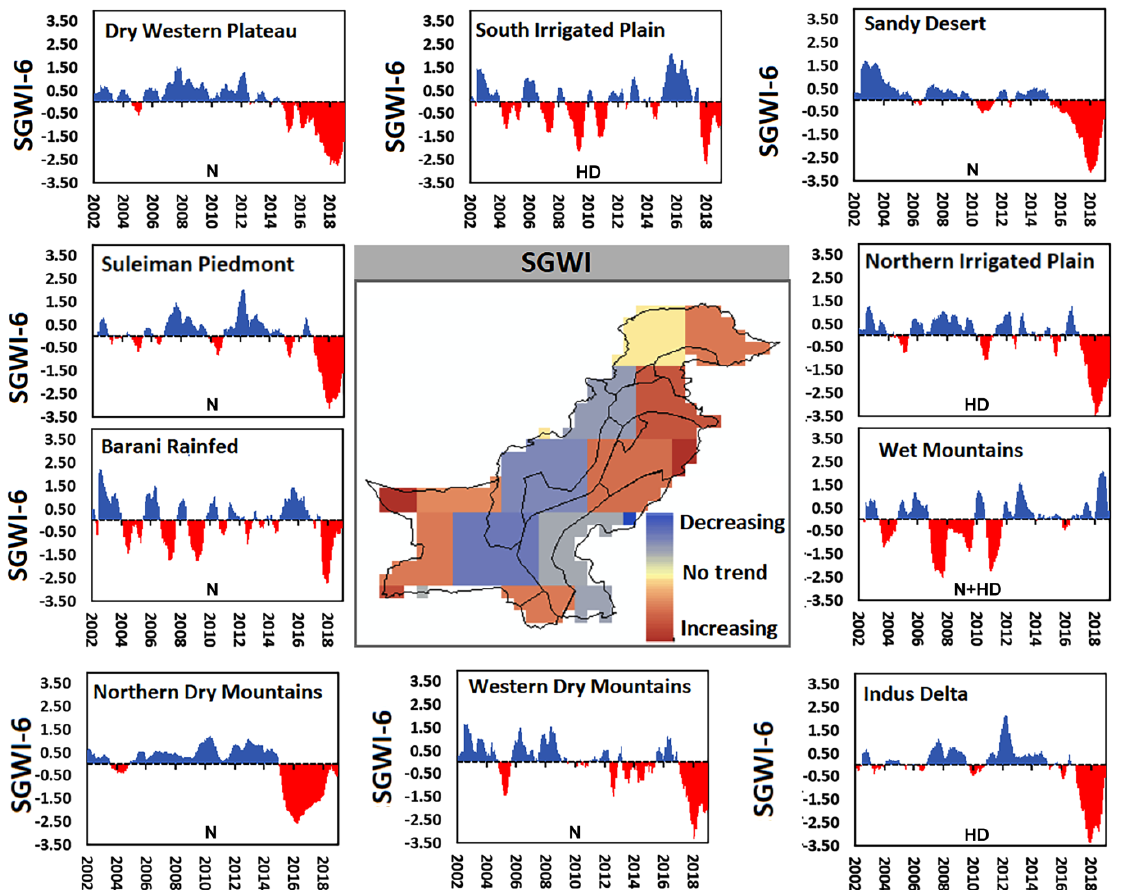
Figure 5. Spatial trend and time series of standardized groundwater storage index at a 6-month timeframe (SGWI-6) for 10 different AEZs. Note: N and HD represent natural and human-disturb zones, respectively.